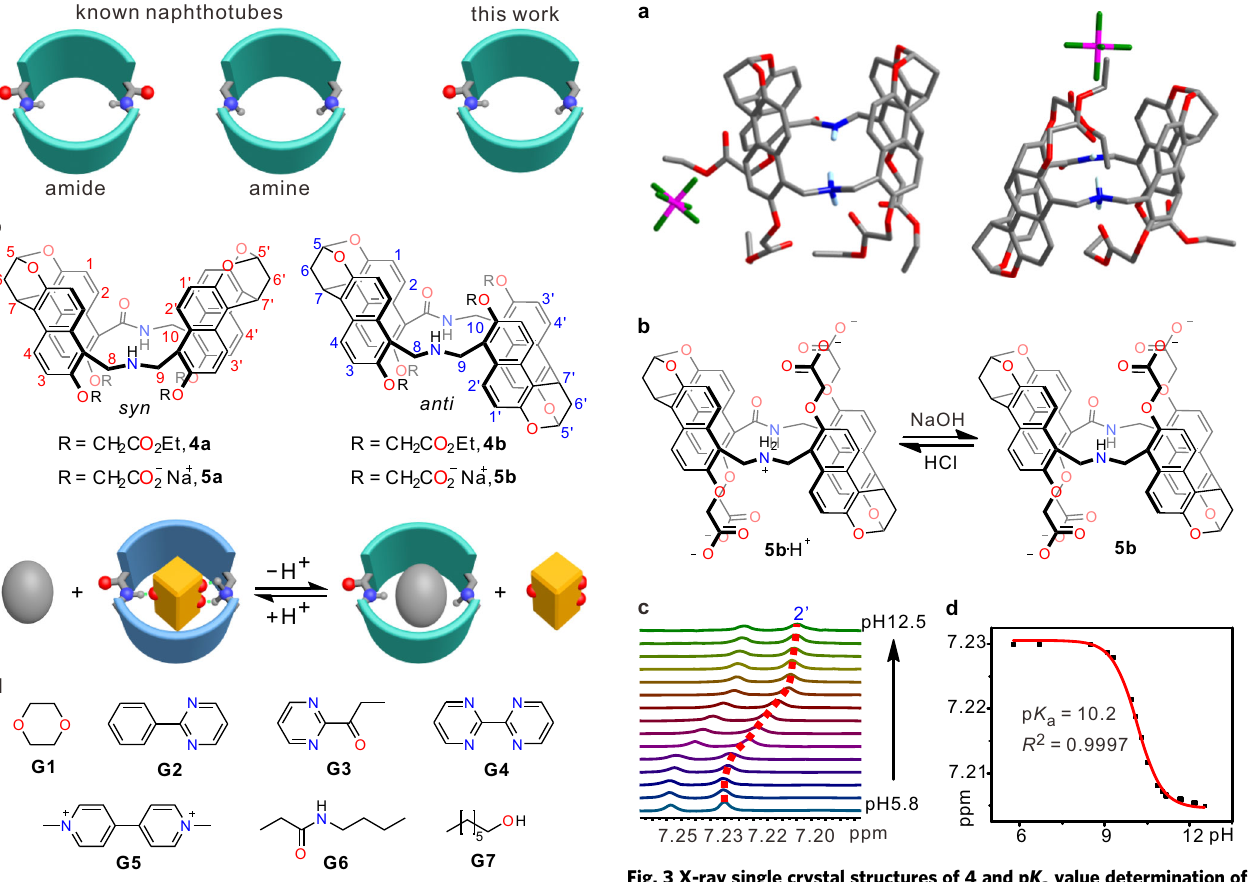
Fig. 2 Design concept of pH-responsive naphthotubes and chemical structures of the hosts and the guests involved in this research. a Cartoon representation of the design of the pH-responsive naphthotubes by combining the features of amide and amine naphthotubes. The sidewalls of naphthotubes are colored as celeste; oxygen, red; nitrogen, blue. b Chemical structures of the naphthotubes ( 4 and 5 ) with the amide and secondary amine groups in the cavities. c Cartoon representation of switchable bifunctional molecular recognition in water using the pH- responsive naphthotubes. The sidewalls of protonated naphthotubes are colored as blue. d Chemical structures of the guests involved in this research. The counter anion of G5 is Cl − .